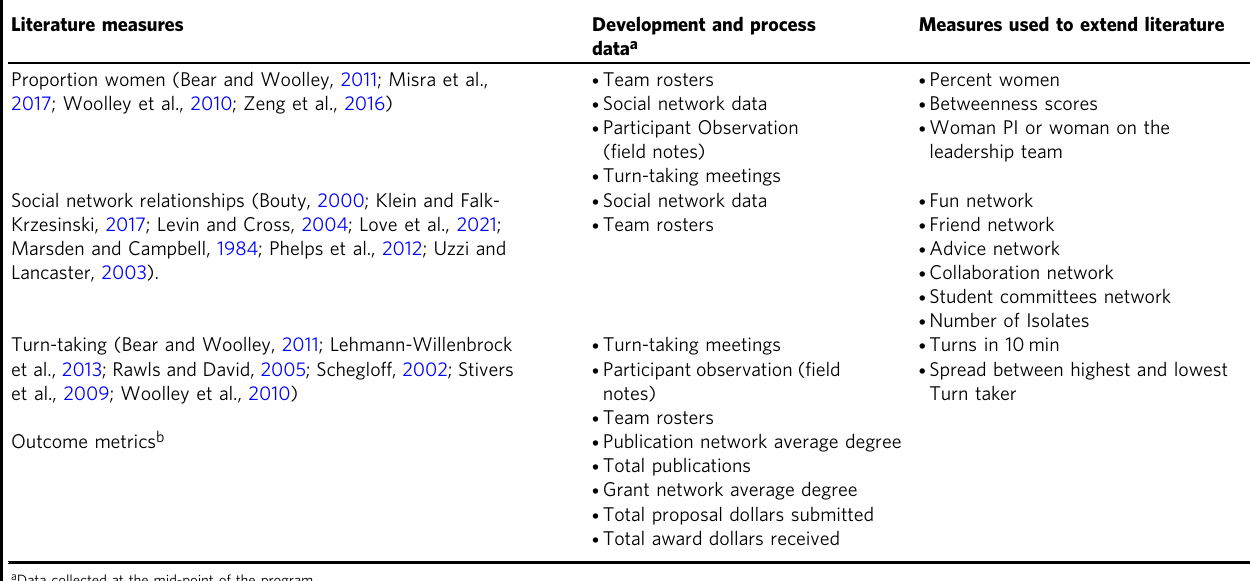
Table 1 Process, development, and outcome